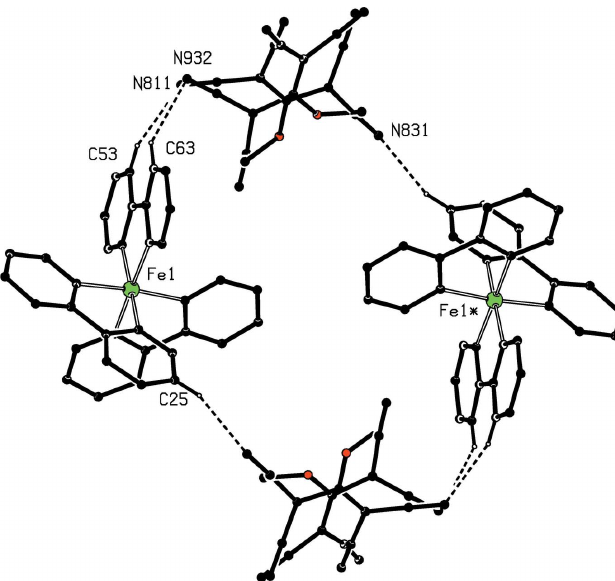
Figure 9 Part of the crystal structure of compound (I) showing the formation of the hydrogen-bonded ring motif, which links the (100) sheets. For the sake of clarity, the type 1 anion and the water molecule, the H atoms not involved in the motif shown, and the unit-cell outline have all been omitted. The Fe atom marked with an asterisk (*) is at the symmetry position (1 (cid:4) x , 1 (cid:4) y , 1 (cid:4) z ).